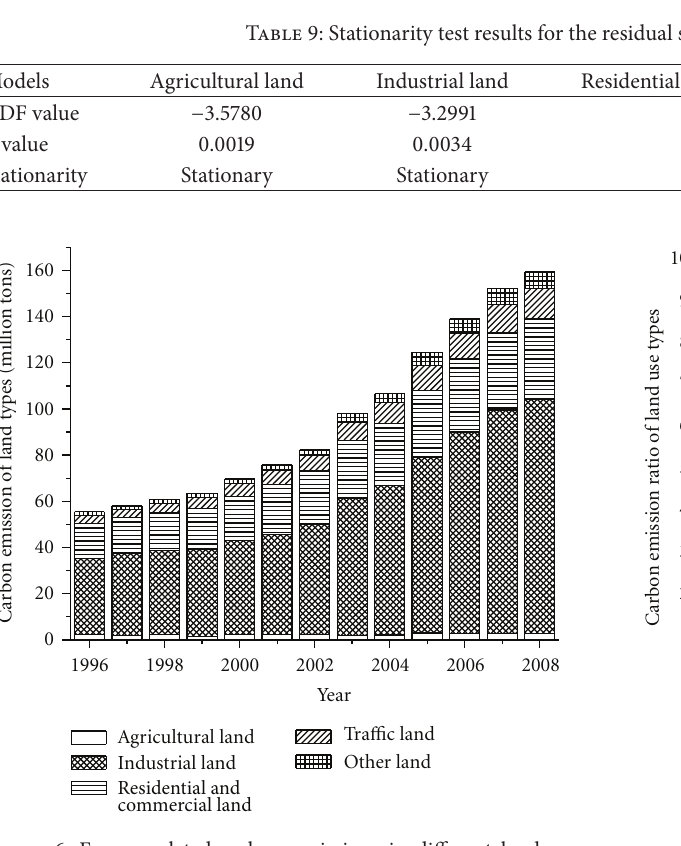
land use distribution structures is crucial. The coefficients of the models indicate that centralize the industrial land and decentralize the residential and commercial land can reduce the carbon emission intensity, respectively. In traffic land, both can reduce energy-related carbon emission